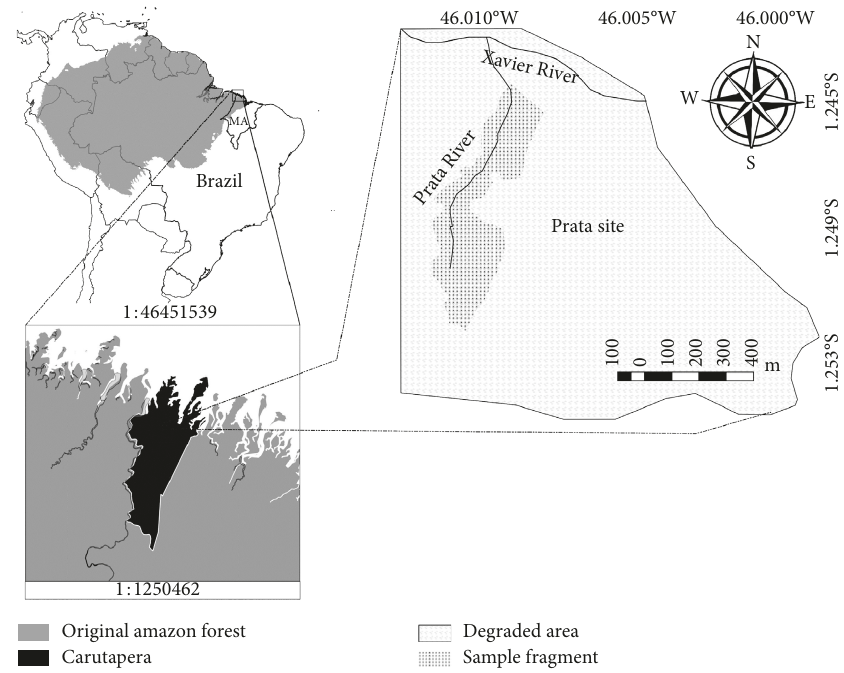
Figure 1: Geographic location of the study area in the municipality of Carutapera, Maranhão,